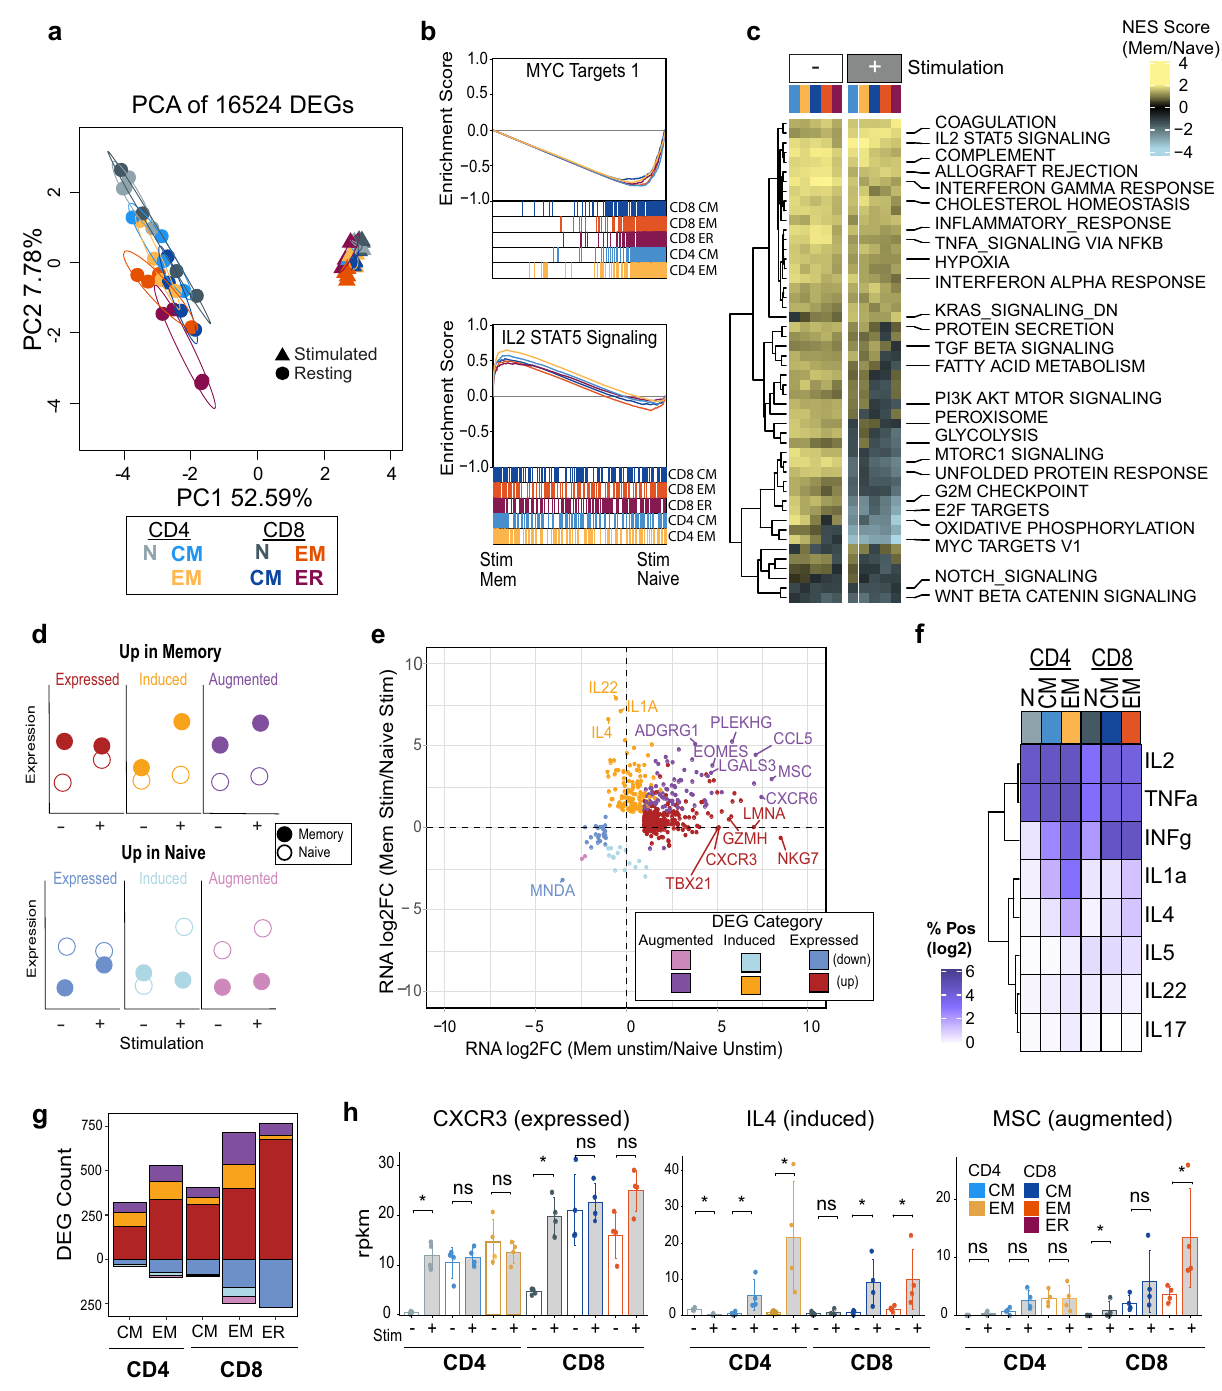
Fig. 7 MTC induce or augment unique gene expression programs after stimulation. a PC analysis plot of DEG for resting (circle) and stimulated (triangle) memory and naïve T-cell samples. b GSEA plots for indicated gene sets showing the enrichment score for each stimulated MTC subset as compared to stimulated naïve T cells. c Heatmap of normalized enrichment scores (NES) from GSEA of both stimulated and unstimulated MTC compared to respective naïve T cells. d Schematic describing examples of DEG categorization; before and after stimulation (Stim). e Scatter plot showing log 2 FC of DEG in unstimulated vs. stimulated MTC. Dots are colored according to DEG category as indicated. f Heatmap showing log 2 transformation of the percent of cells positive for respective cytokine protein expression. g Bar plot showing number of DEG compared to naïve T cells belonging to Expressed, Induced, or Augmented categories for each memory subset. h Gene expression bar plots showing rpkm for indicated genes. Error bars represent ±1 SD from mean in each group. Asterisks indicate relevant signi fi cant differences as detected by DESeq2